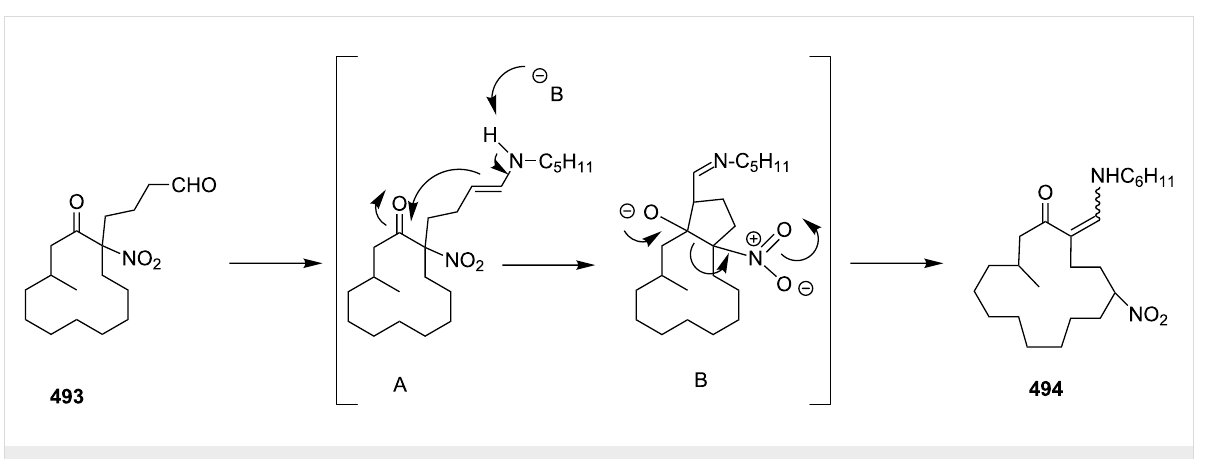
Figure 13: Mechanism of the formation of compound 494